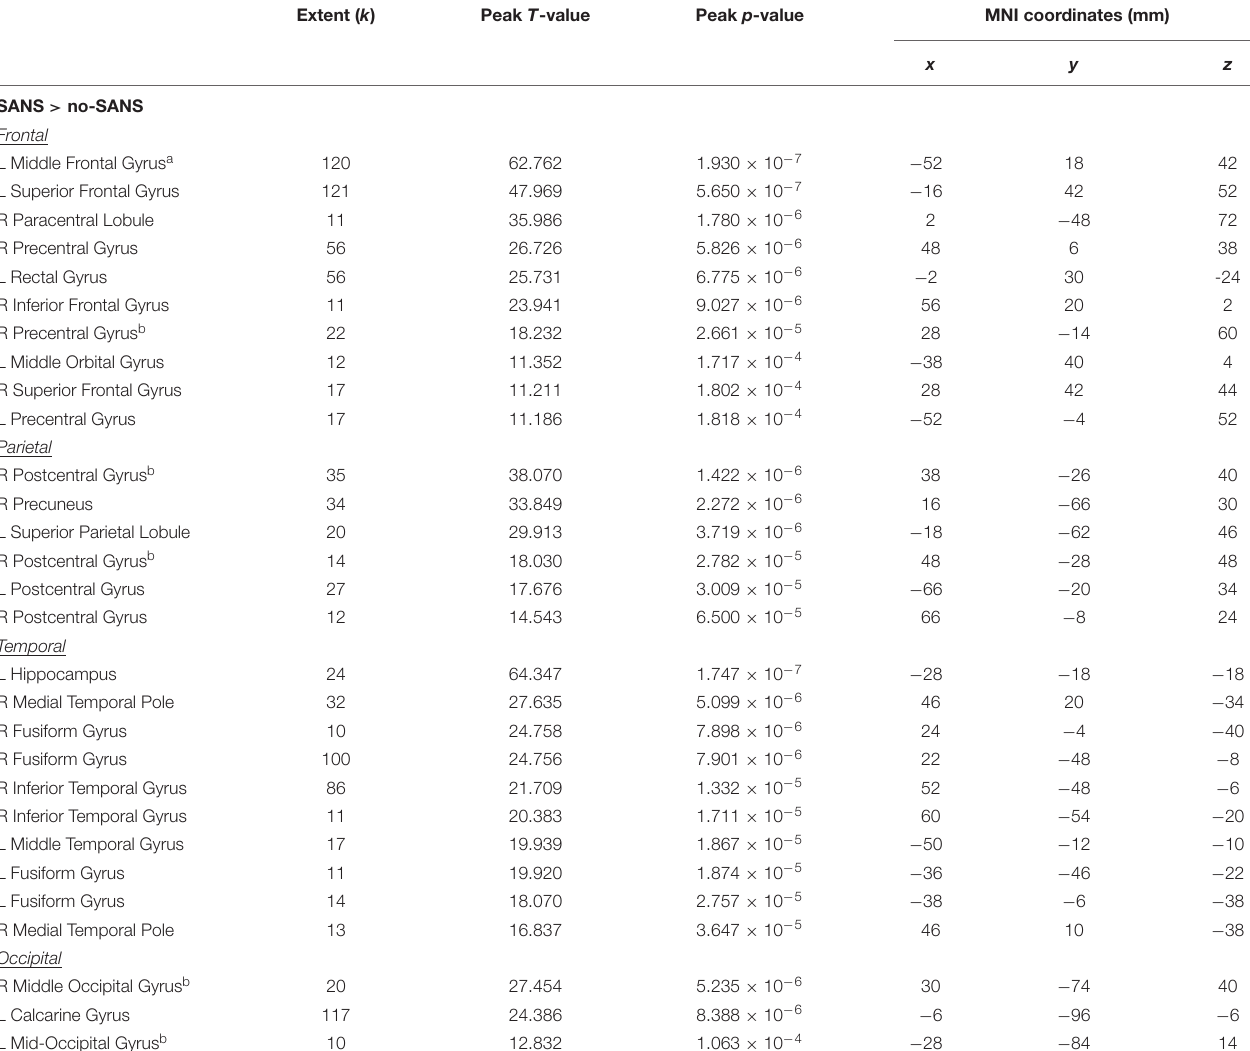
TABLE 7 | Regions where SANS subjects showed greater correlations compared to no-SANS subjects between pre- to post HDBR + CO 2 change in visual dependence balance ratio and pre- to post-HDBR + CO 2 change in brain activation during vestibular stimulation. Extent ( k ) Peak T -value Peak p -value MNI coordinates